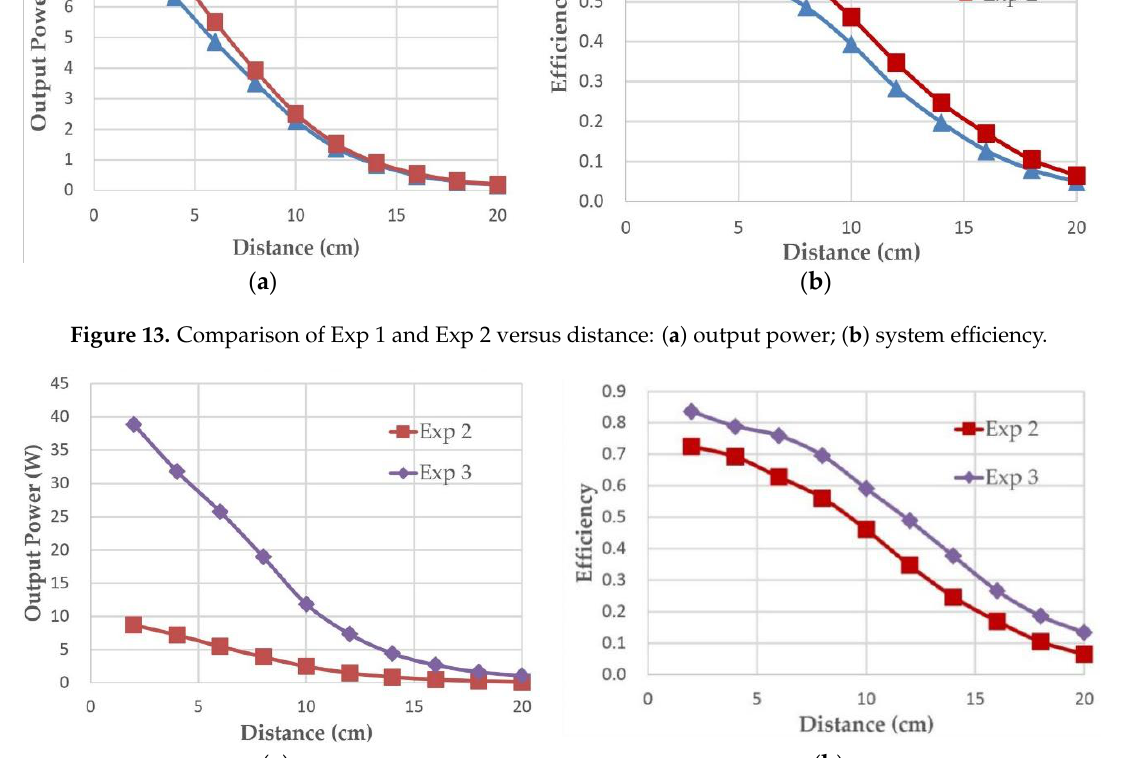
Figure 14. Comparison of Exp 2 and Exp 3 versus distance: ( a ) output power; ( b ) system efficiency.